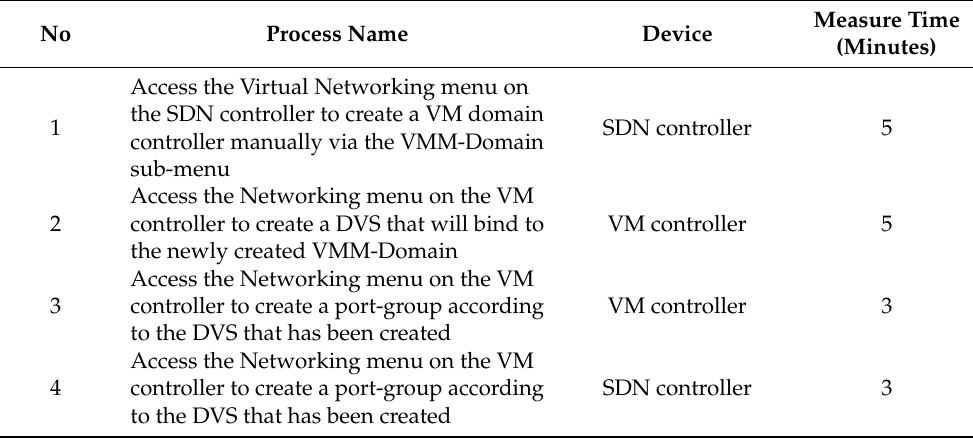
Table 8. Measuring time of new VM controller integration with SDN controller manually.